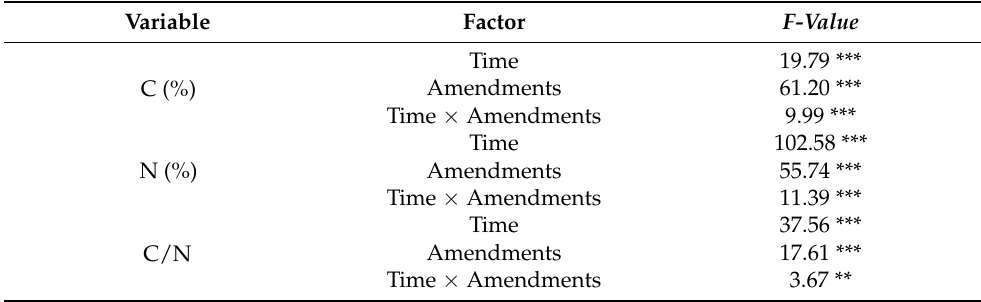
Table 1. F-Values and significance for the effects and factors and their interactions for the variables analyzed by a two-way